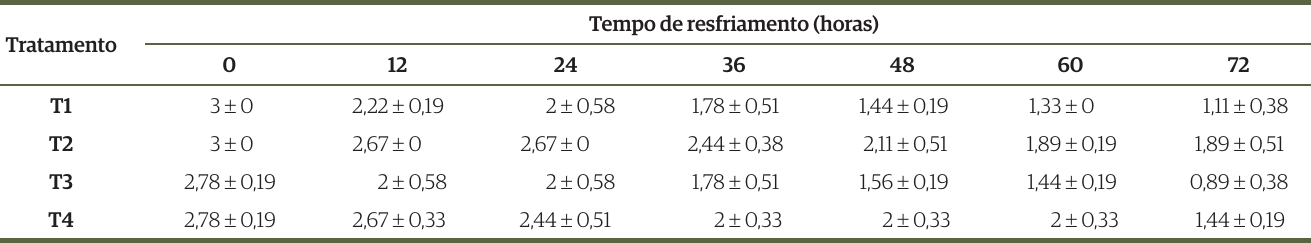
Tabela 2. Médias ± desvios padrões de vigor do sêmen submetido à refrigeração, avaliados durante o periodo de 72 horas, com acréscimo ou não de α -Tocoferol em diluidor, nas temperaturas de 5 e 15 °C.